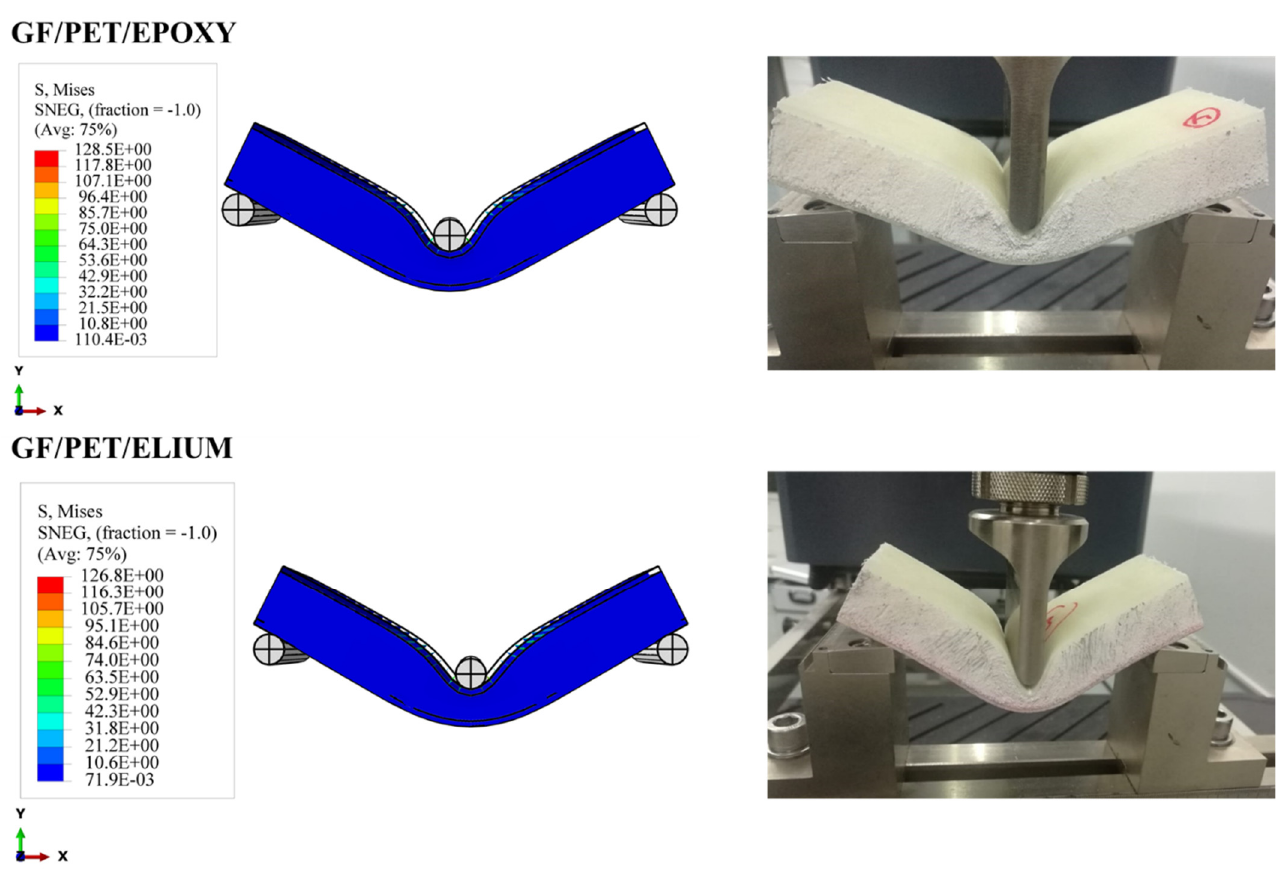
Figure 8. Experimental and numerical damage mechanisms under the flexural load of GF/PET/Epoxy and GF/PET/Elium Sandwich composites.